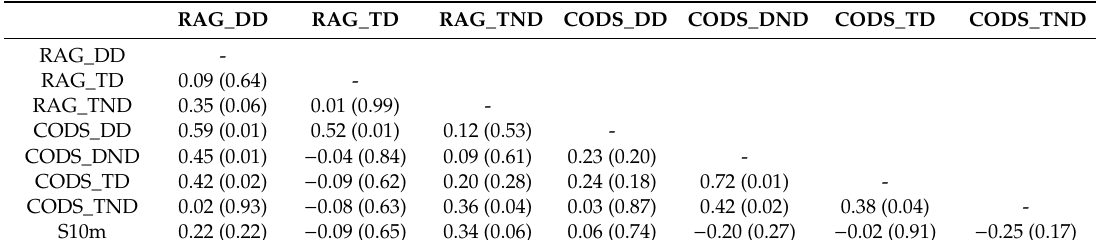
Table 5. Pearson product moment correlation coefficients with corresponding significance level (p) between the studied agility variables *.